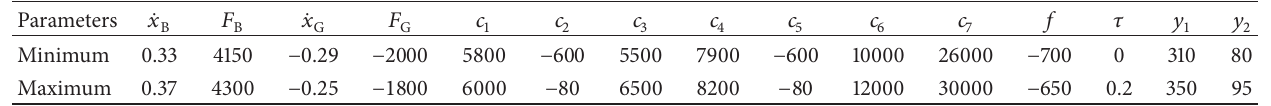
Table 2: Constraints of parameters.